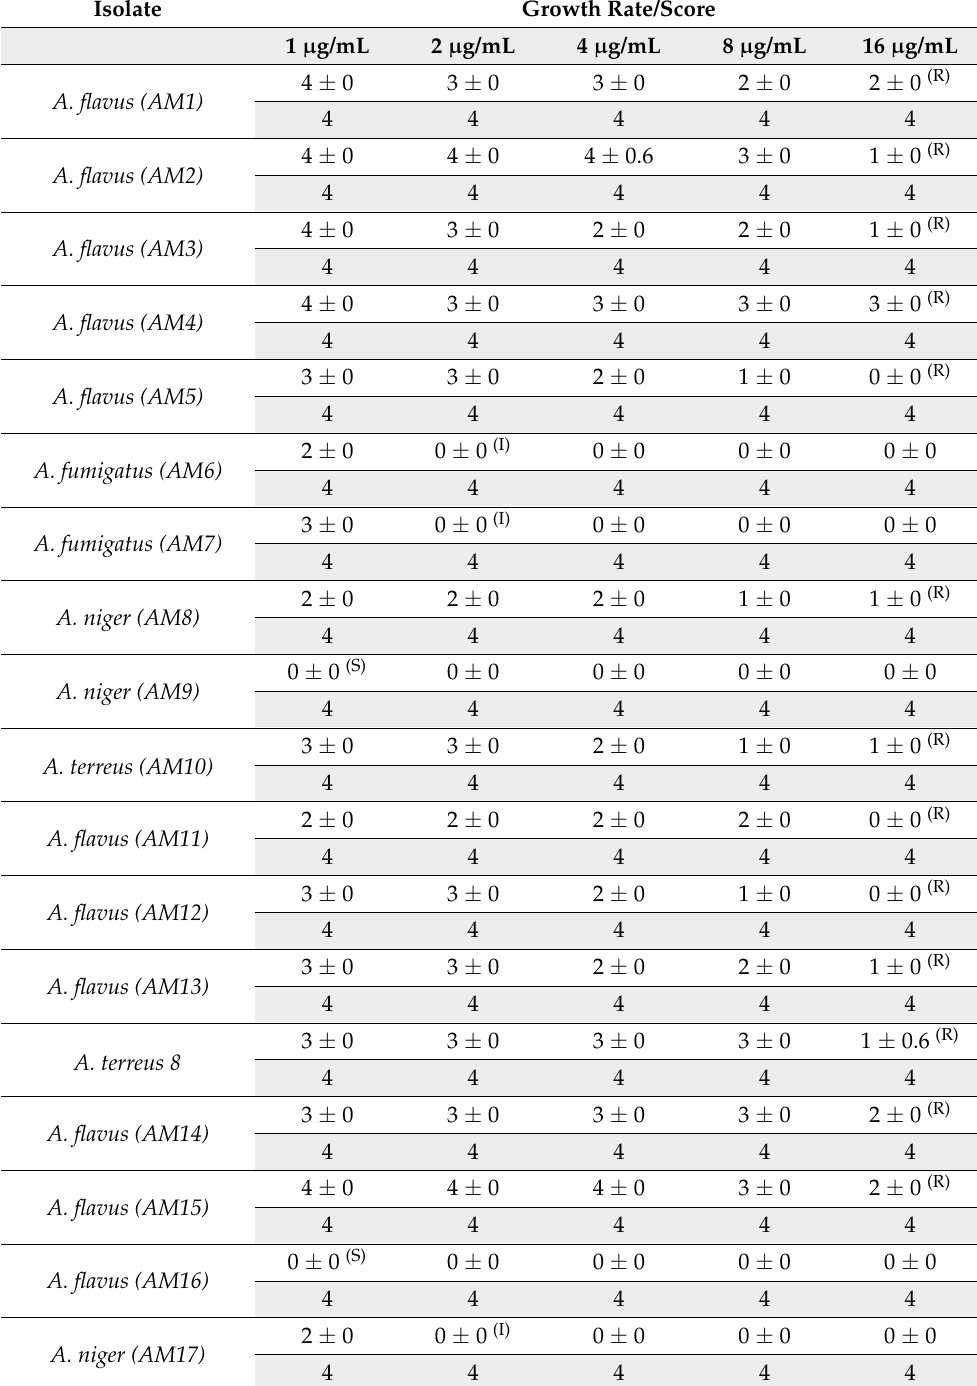
Table 6. Susceptibility of fungal species to different concentrations of Voriconazole (broth microdilu- tion